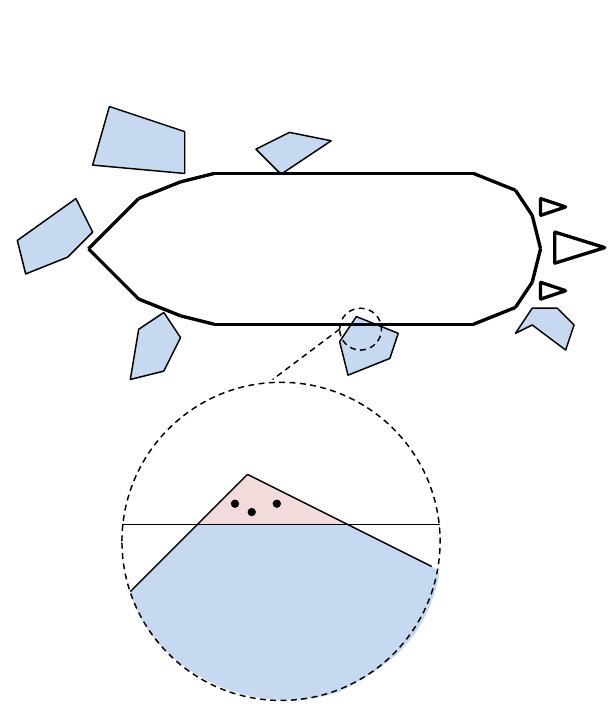
Figure 20: Intersection patch between a breakable ice floe and the vessel.